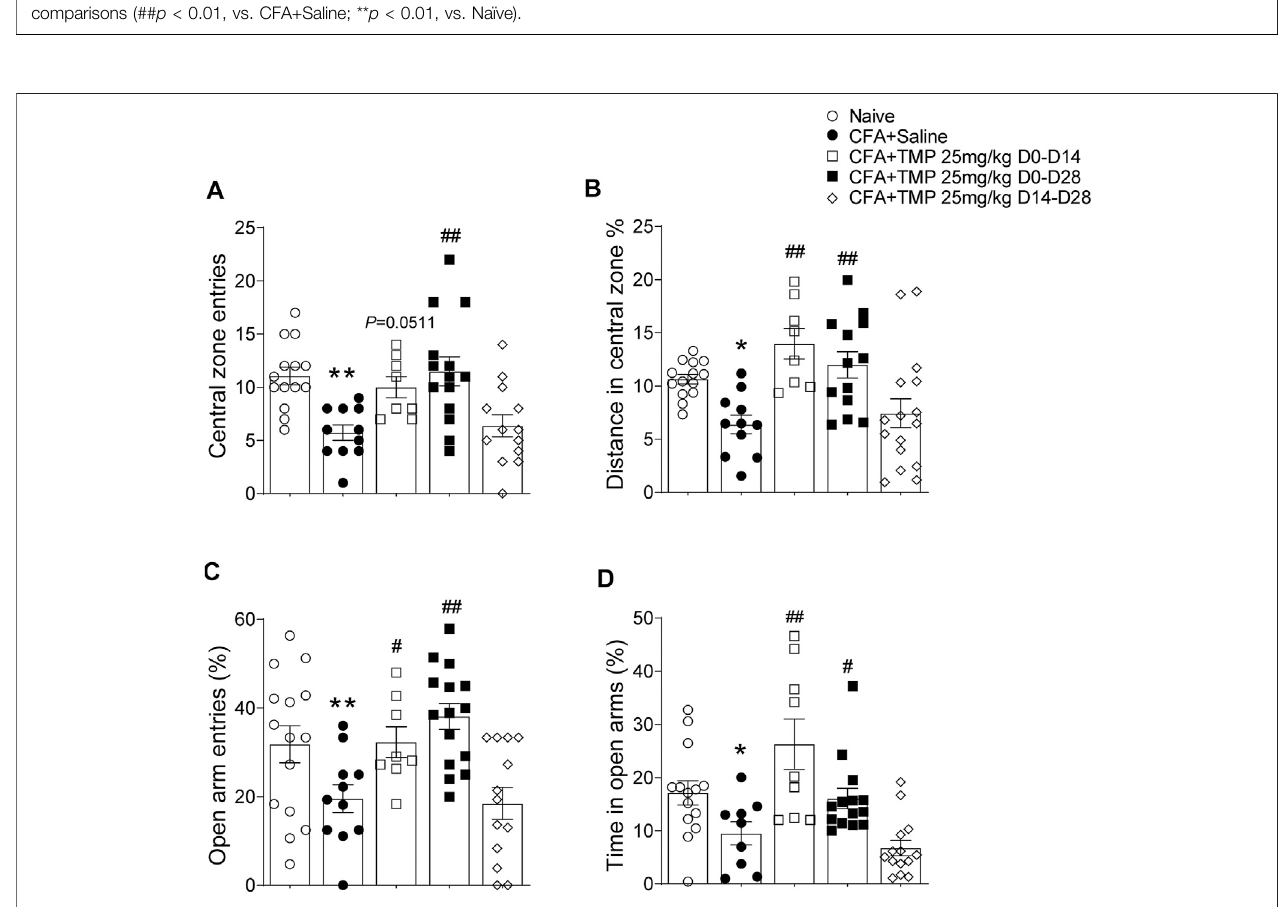
FIGURE 7 | Time dependent effects of TMP on anxiety behaviors in CFA induced pain. (A, B) Effects on entries (A) and distance percentage (B) in central zone of open fi eld test with different TMP administration periods. (C, D) Effects on entries (C) and time percentage (D) in open arms of EPM test with TMP with different TMP administration periods as indicated (25 mg/kg, i.p. D0-D14, D0-D28 and D14-D28 vs. saline). Statistical analysis was performed by one way ANOVA, followed by post Dunnett ’ s multiple comparisons (* p < 0.05, ** p < 0.01, vs. Naïve; # p < 0.05, ## p < 0.01, vs. CFA+Saline).